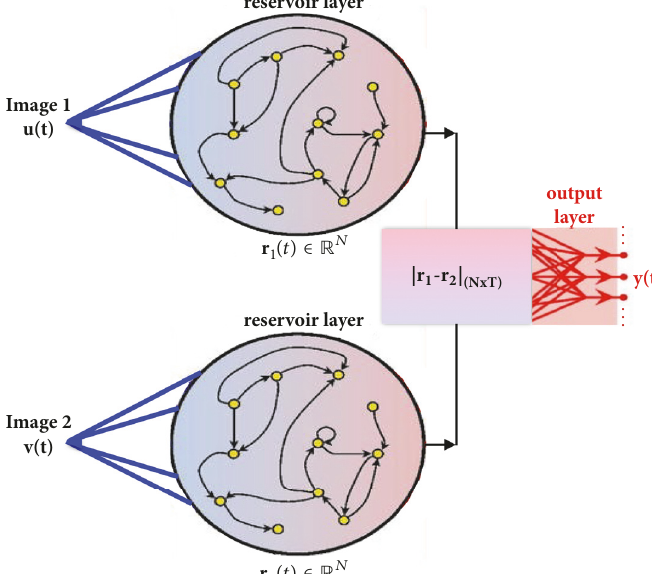
󳨀→ 𝑢(𝑡) and 󳨀→ V (𝑡) , reservoir state vectors by